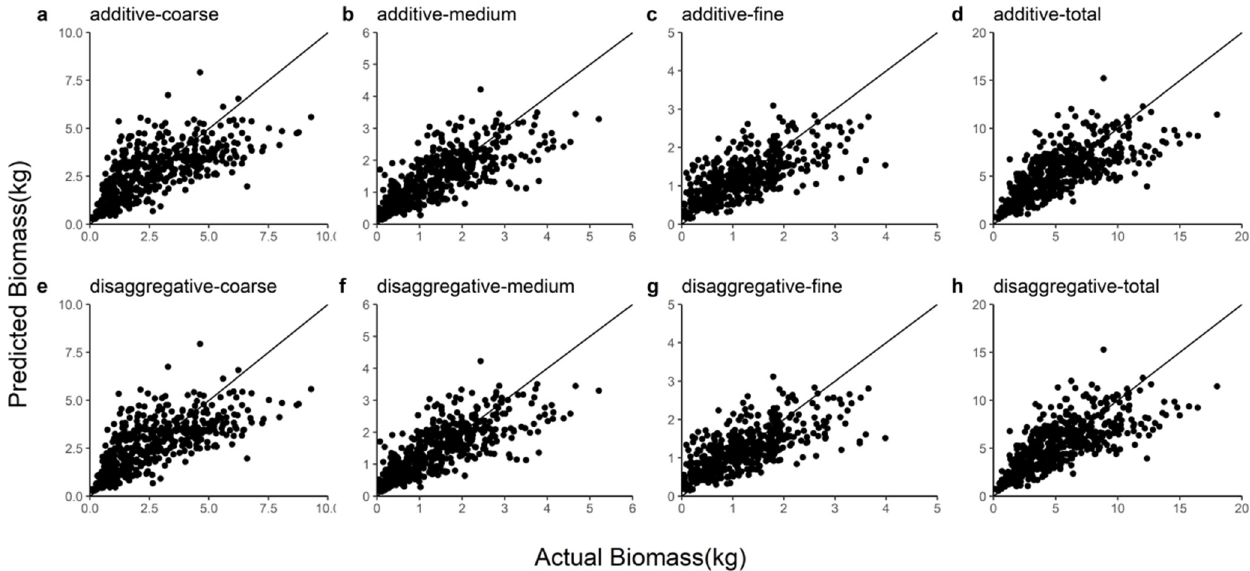
Figure 3 . Comparison of coarse root, medium root, fine root, and total root biomass predictions for the additive and disaggregated models. ( a – d ) represent the predicted coarse, medium, fine and total roots from the additive model; ( e – h ) represent the coarse root, medium root, fine root and total root predicted by the disaggregated model.